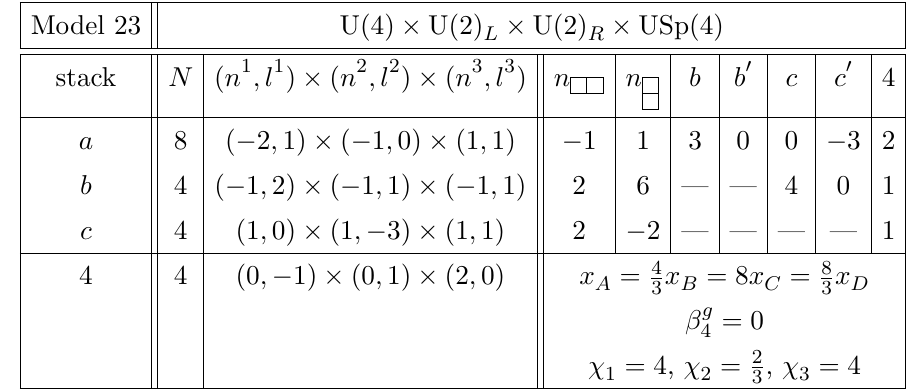
Table 30 . D6-brane configurations and intersection numbers of Model 23, and its MSSM